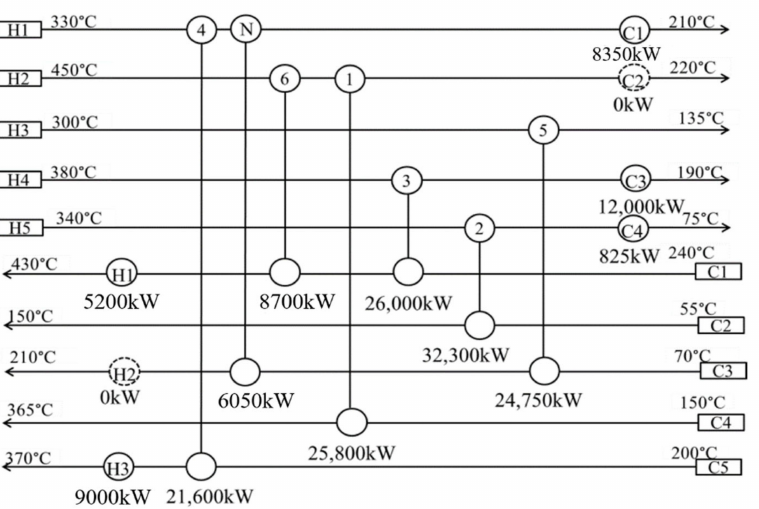
Figure 21. The first-step modification for retrofit HEN by adding a new plate heat